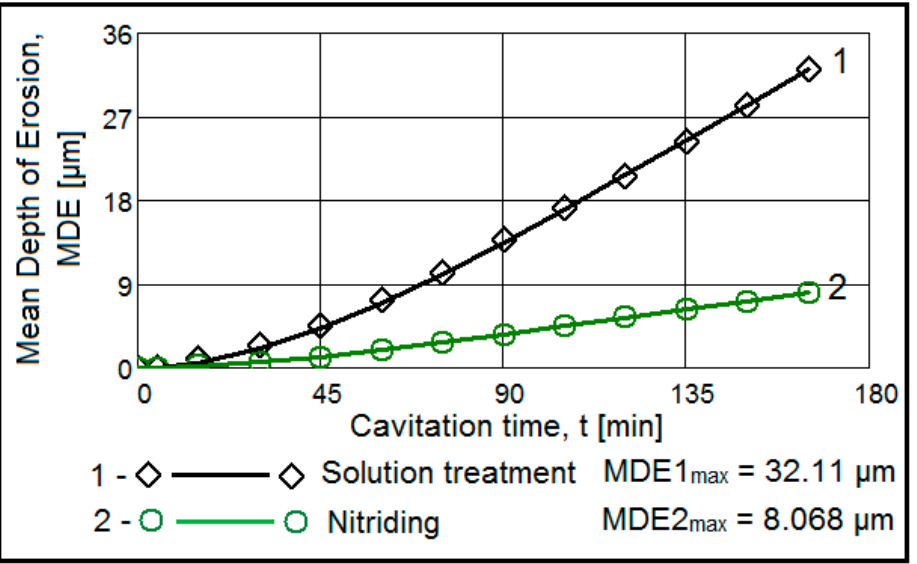
Figure 2. Evolution of mean depth of erosion with the cavitation time (1—solution treatment; 2— solution treatment + nitriding).